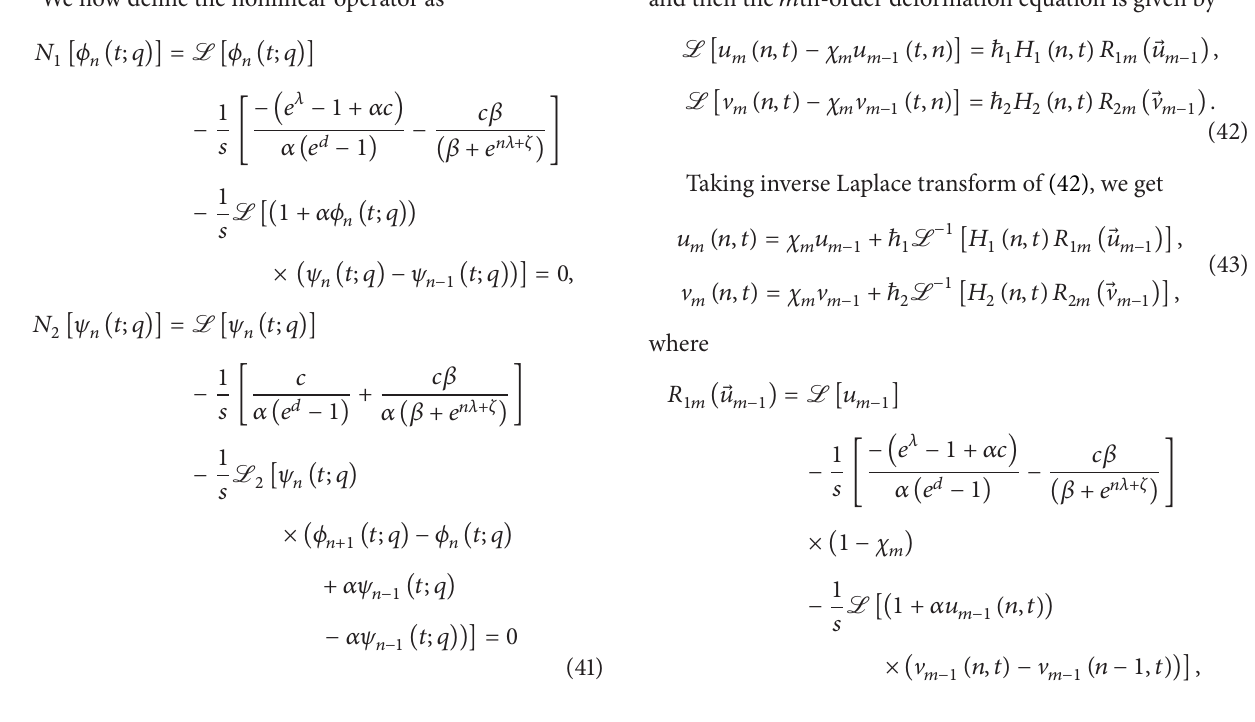
Figure 2: The 2nd-order approximate solution (31) when 𝜇 = 0